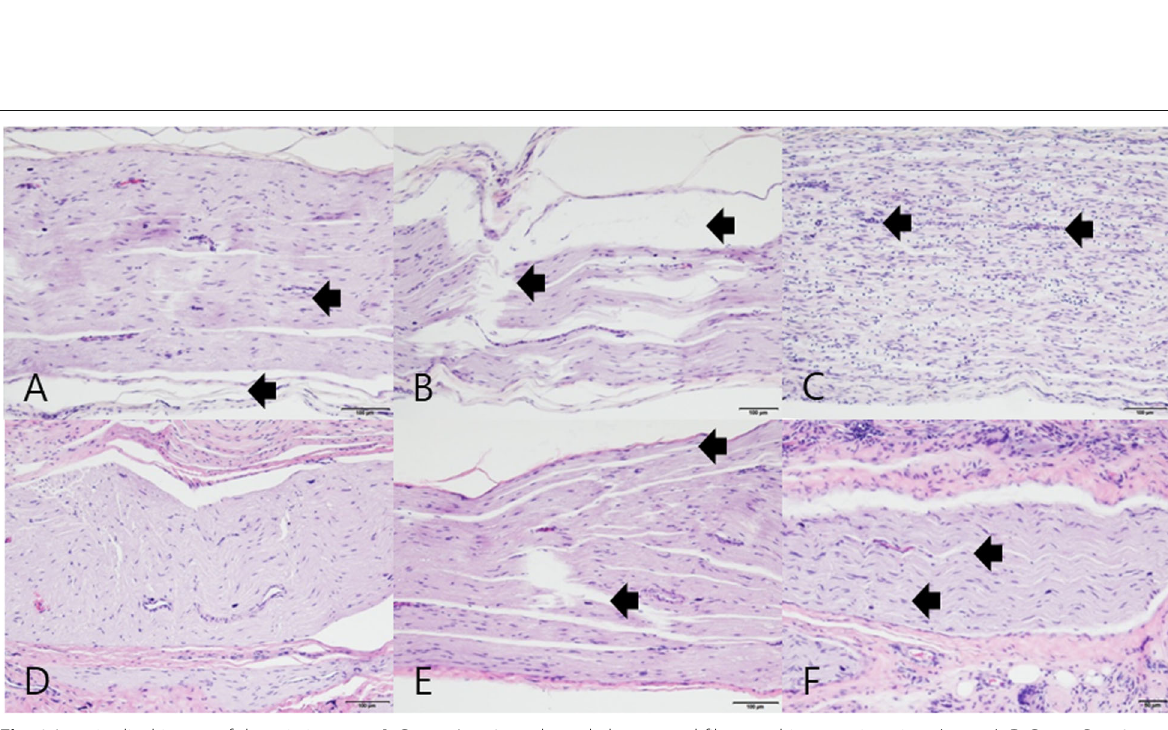
Fig. 9 Longitudinal image of the sciatic nerve. A Group A at 2 weeks: orderly arranged fibers and intact epineurium (arrows). B Group B at 2 weeks: edema and severance (arrows). ( C ) Group C at 2 weeks: arrows indicate misarranged fibers with lymphocyte infiltration. ( D ) Group A at 4 weeks: no significant difference relative to the findings at 2 weeks. ( E ) Group B at 4 weeks: decreased edema and rupture relative to that previously observed (arrows). Well-defined curling and vacuolization are observed. ( F ) Group C at 4 weeks: orderly arranged fibers showing slight axonal swelling (arrows). (Hematoxylin and eosin staining, ×10